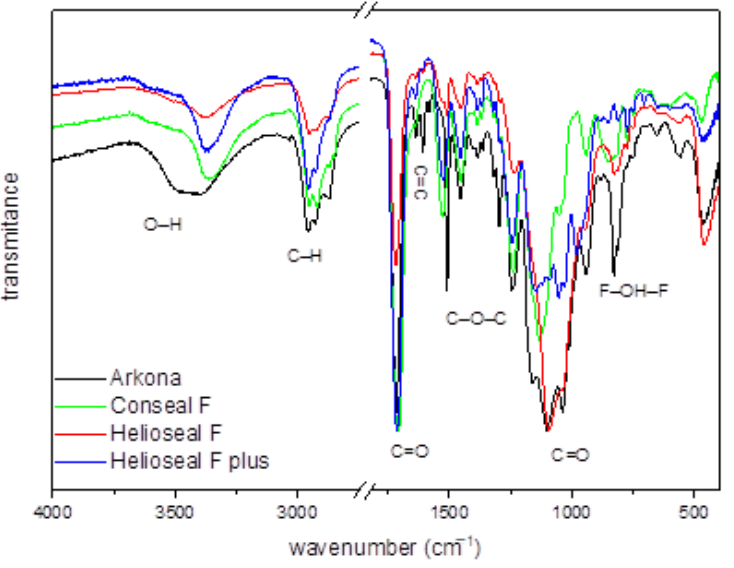
Figure 3. FTIR spectra of different fissure sealant materials. The study was performed for one randomly selected sample of each material: Arkona; Conseal F; Helioseal F; Helioseal F Plus. Table 1. Fluoride ion release (ppm/mg) from fissure sealants into a saline solution (0.9% NaCl). Descriptive data are pre- sented as mean values + standard deviation (SD).